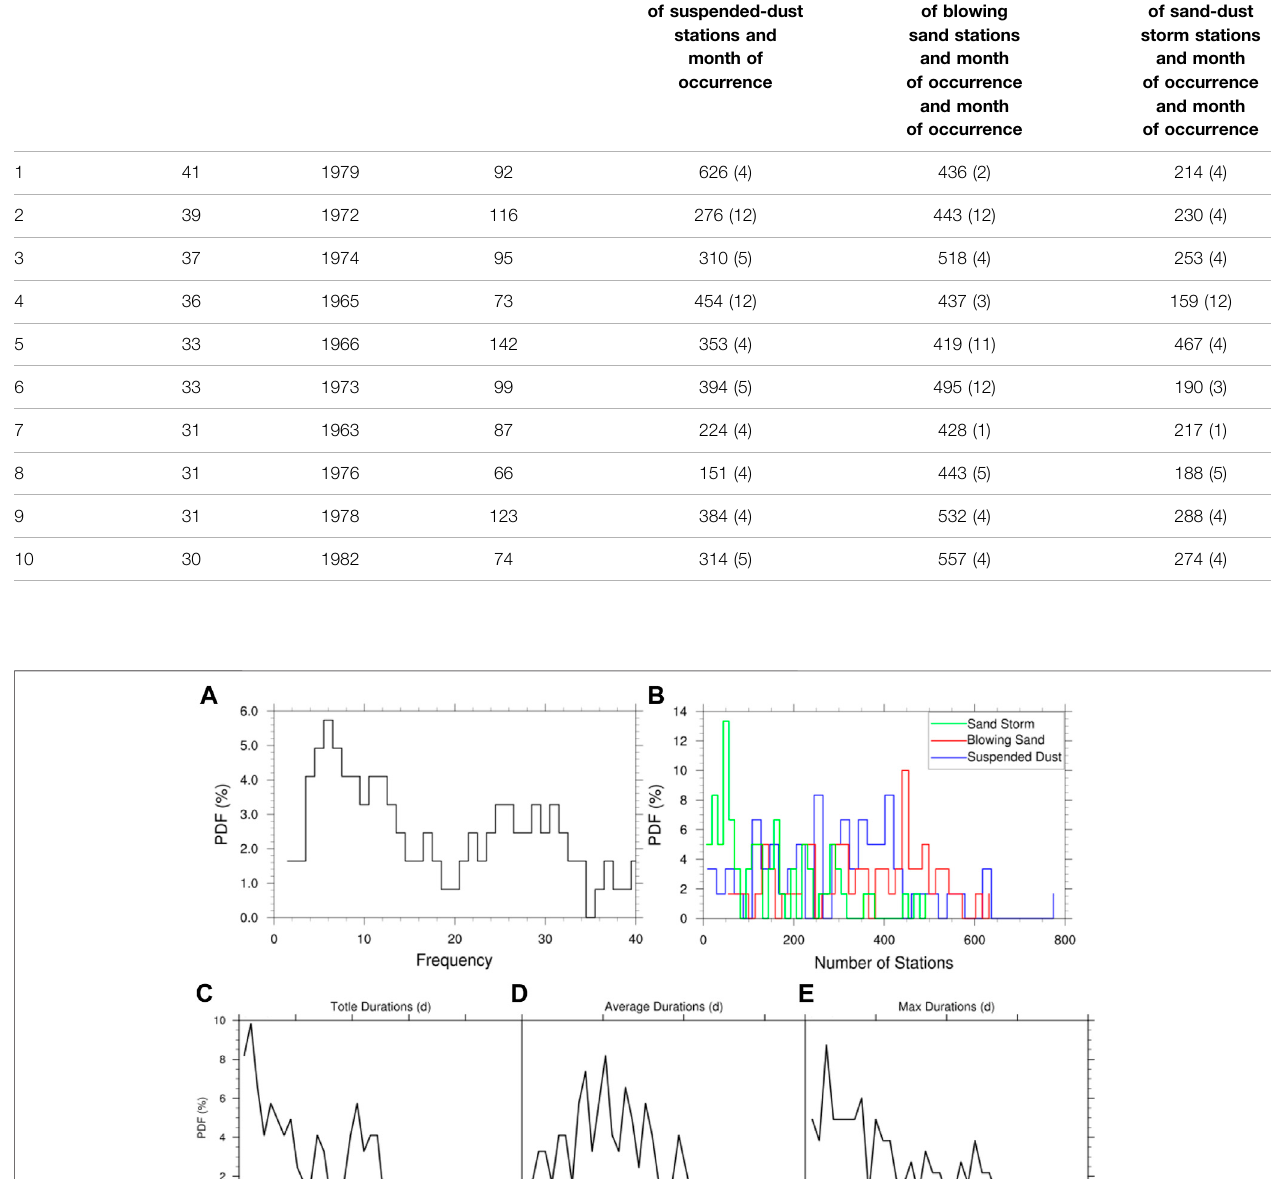
Frontiers in Environmental Science |